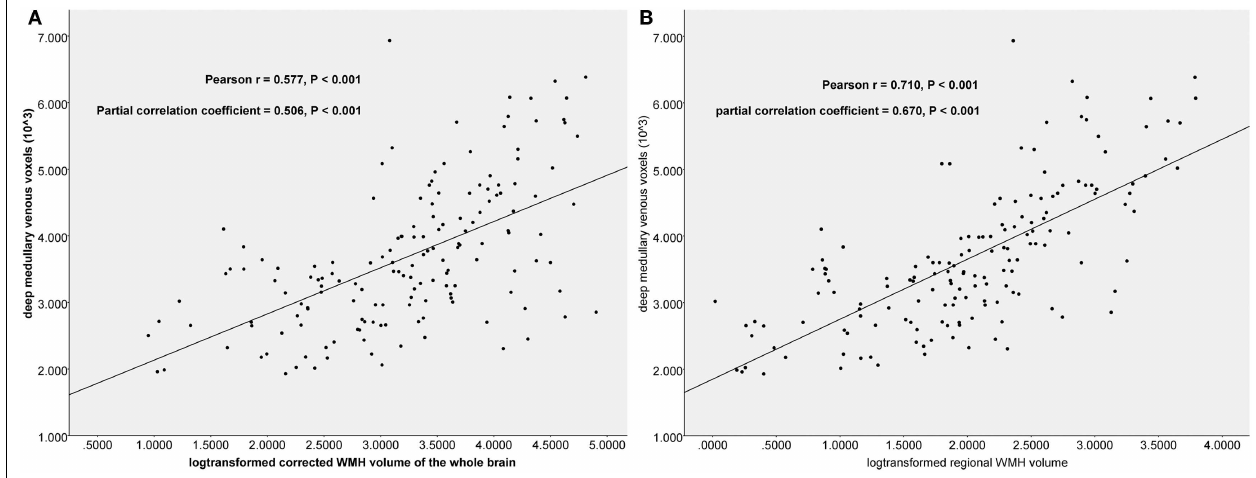
FIGURE 3 |The scatter plots between log-transformed corrected white matter hyperintensity (WMH) volume and number of the deep medullary venous voxels . Partial Pearson’s correlation analysis was used by adjusting